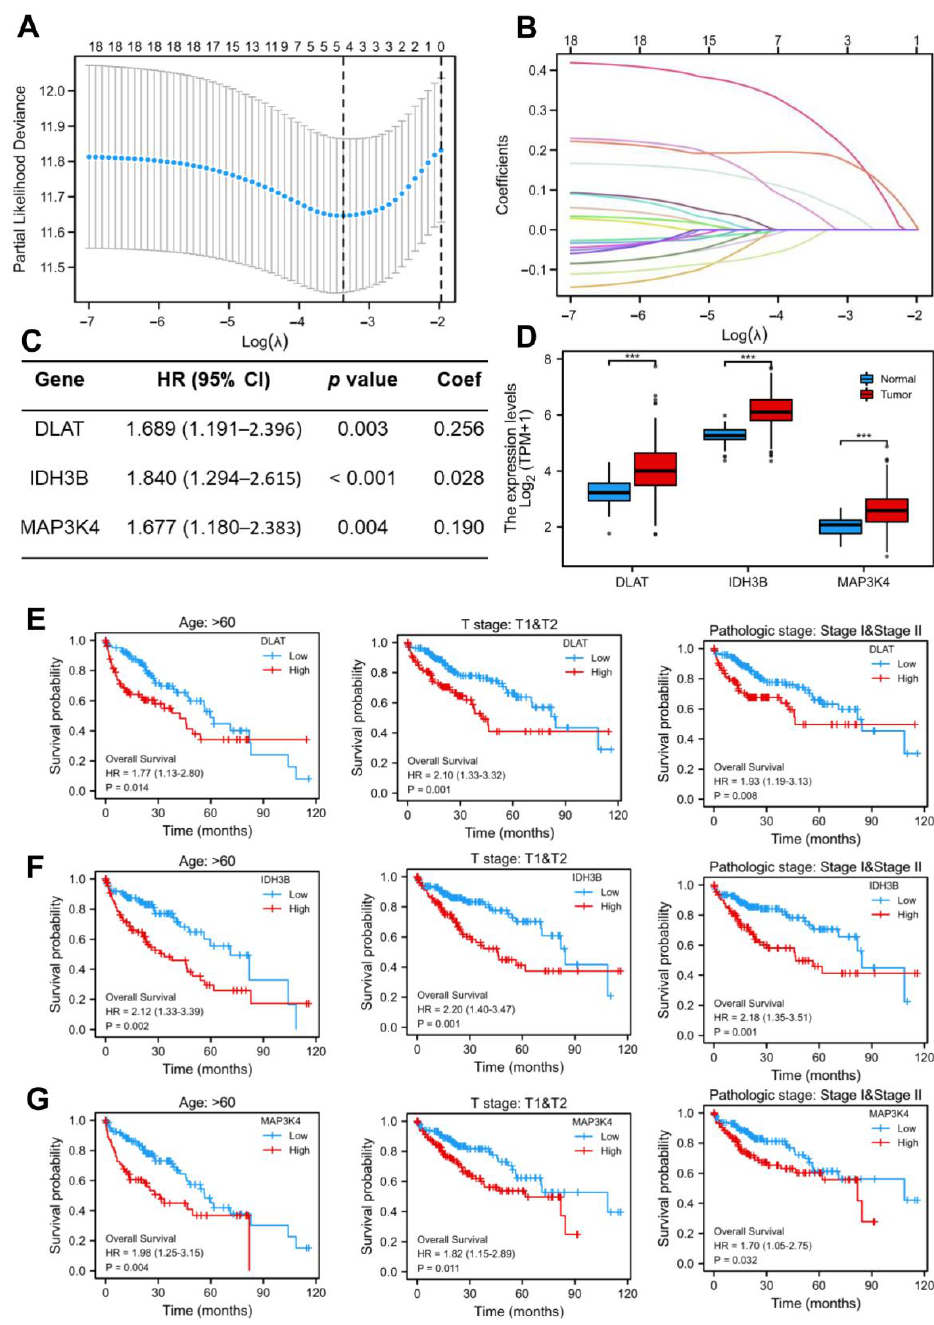
Figure 3. Construction of the LASSO regression model. ( A ) Cross-validation for tuning the parameter selection in the LASSO regression. ( B ) Coefficient profiles in the lasso regression model. The different color lines represented the trajectory of the coefficients for each variable. ( C ) Univariate Cox regression analysis and LASSO coefficient of DLAT, IDH3B, and MAP3K4 in TCGA-LIHC. ( D ) The expression levels of DLAT, IDH3B, and MAP3K4 in TCGA-LIHC. ( E – G ) Prognostic value of DLAT, IDH3B, and MAP3K4 in different subgroups: T3 and T4 stage, pathological stage III and IV, and fibrosis Ishak score 3–6.